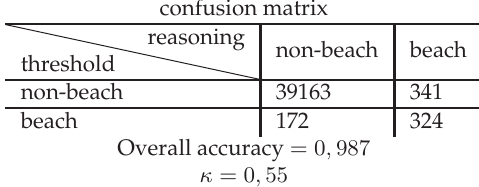
Table 4: Evaluation of ontological detection of beach segments in comparison to expert B classification.